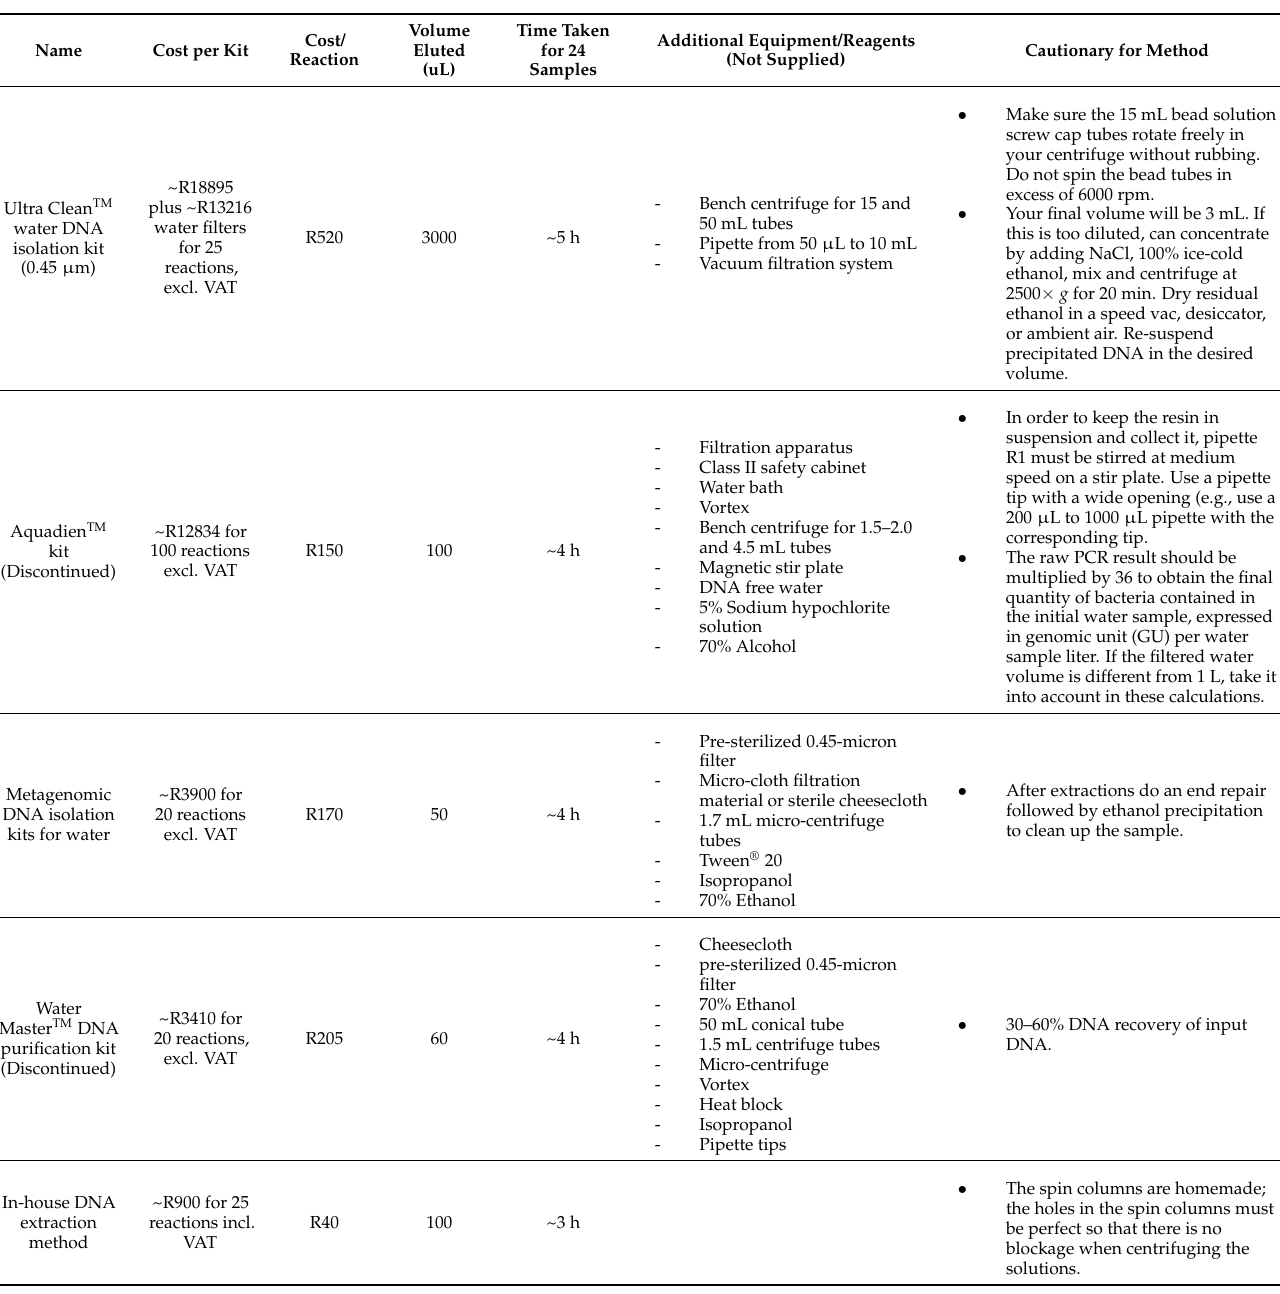
Table 5. Cost comparison of in-house DNA extraction method and commercial DNA extraction water-testing kits, conversion at